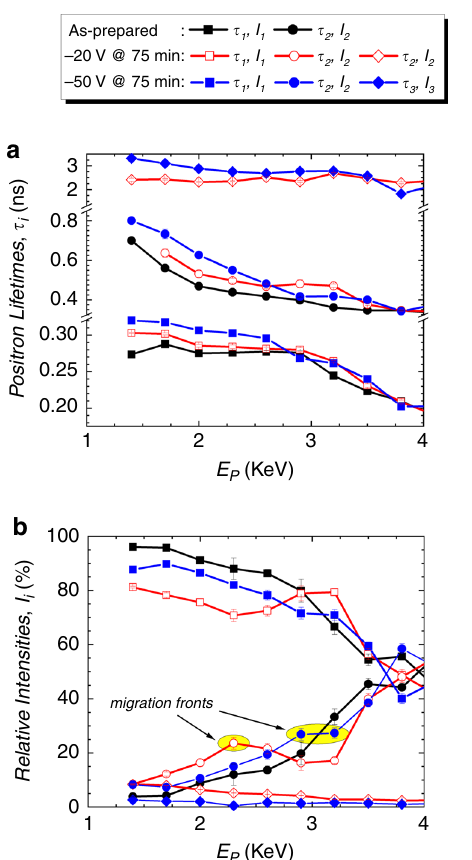
Fig. 4 Defect characterization by variable energy positron annihilation lifetime spectroscopy (VEPALS). a Positron lifetime components τ i = 1 – 3 and b their relative intensities I i = 1 – 3 as a function of positron implantation highlighted in b .